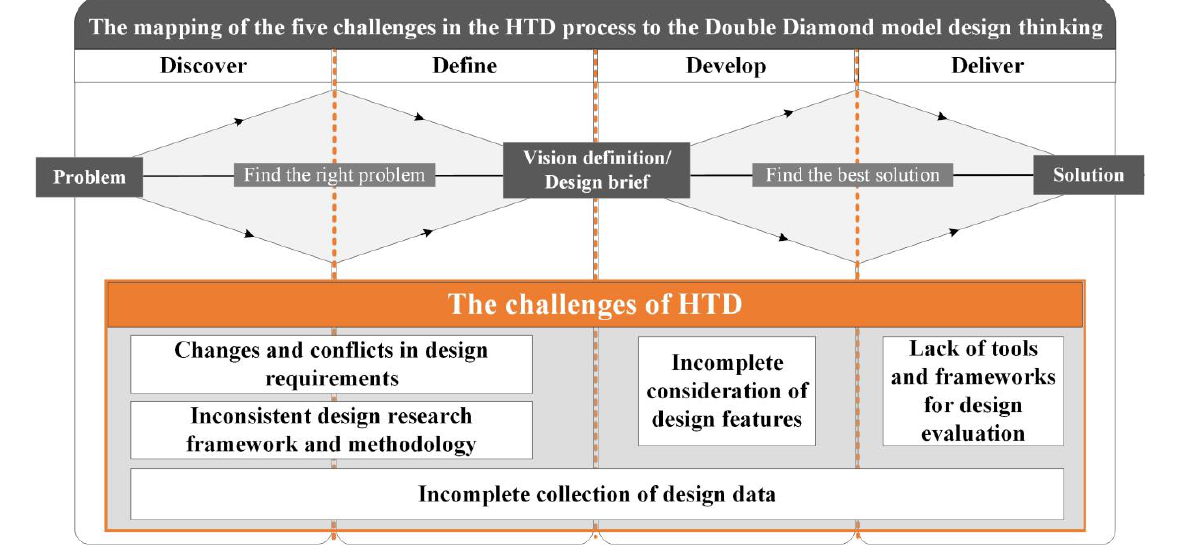
Figure 4. The mapping of the five challenges in the HTD process to the Double Diamond model design thinking (generated by authors).